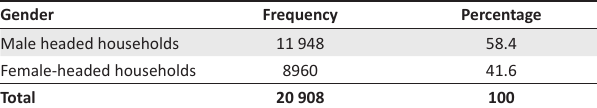
TABLE 3 : Gender distribution of the study. Gender